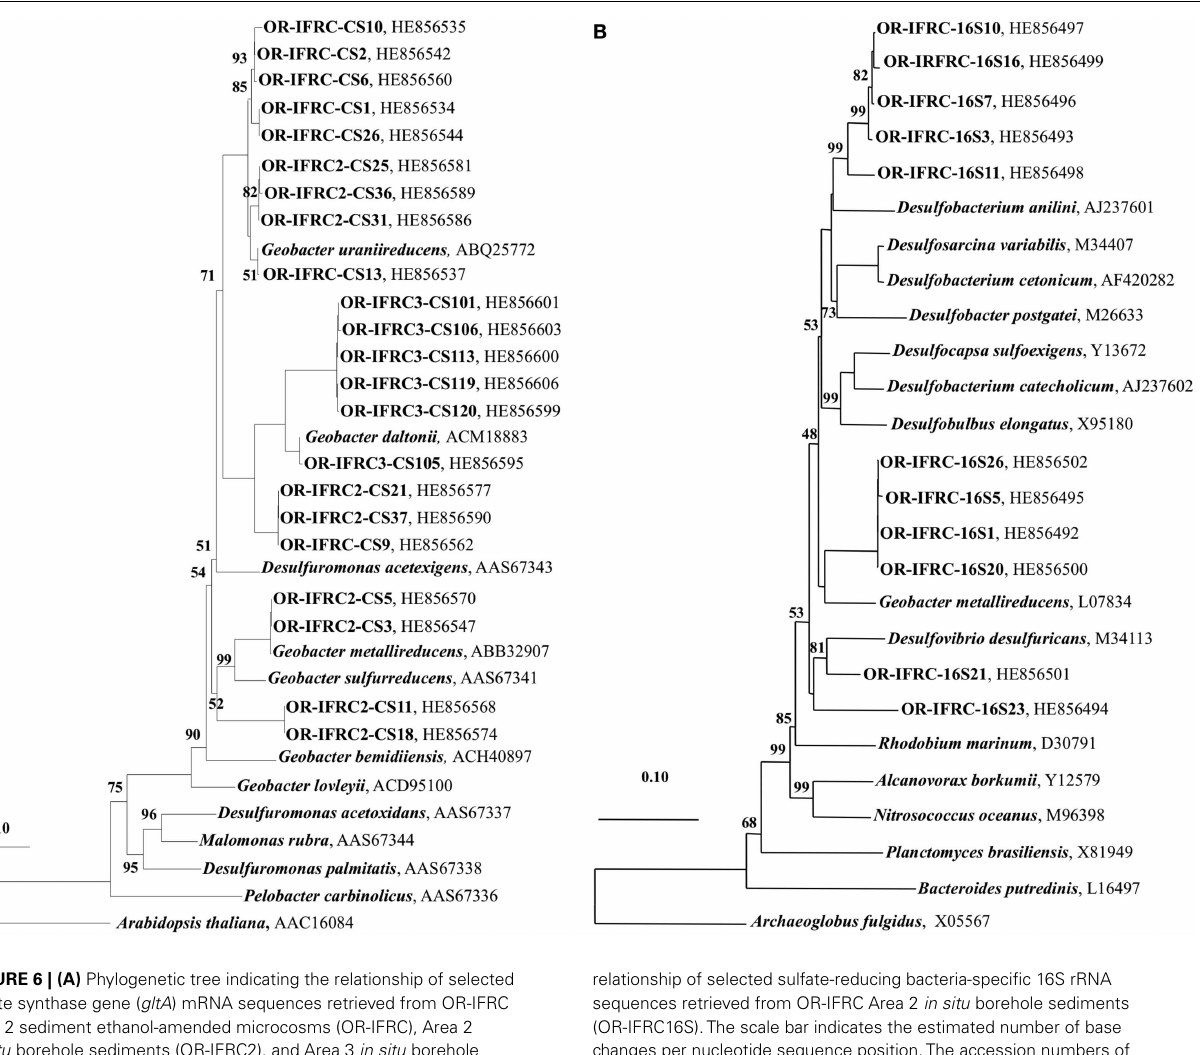
relationship of selected sulfate-reducing bacteria-specific 16S rRNA sequences retrieved from OR-IFRC Area 2 in situ borehole sediments (OR-IFRC16S).The scale bar indicates the estimated number of base changes per nucleotide sequence position.The accession numbers of the sequences are